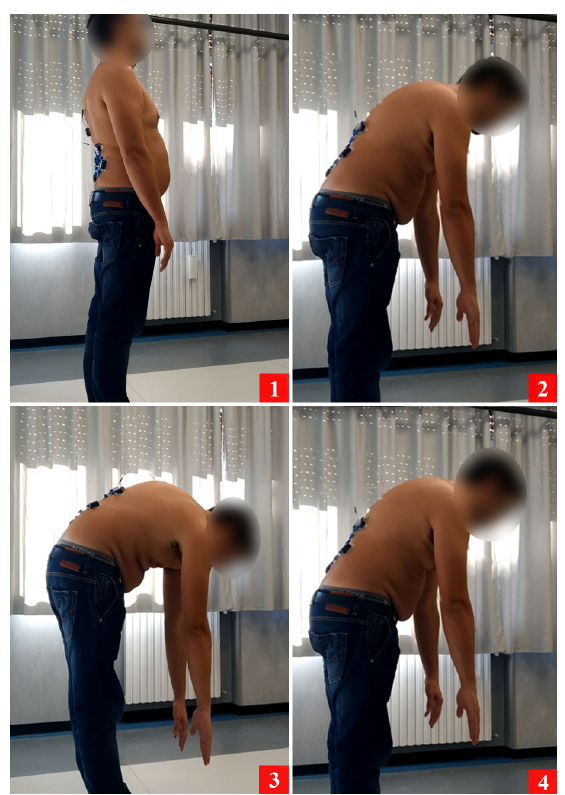
Figure 3. Flexion-extension phases: ( 1 ) standing phase; ( 2 ) flexion phase; ( 3 ) full flexion phase; ( 4 ) extension phase. This forward bend test was repeated for four